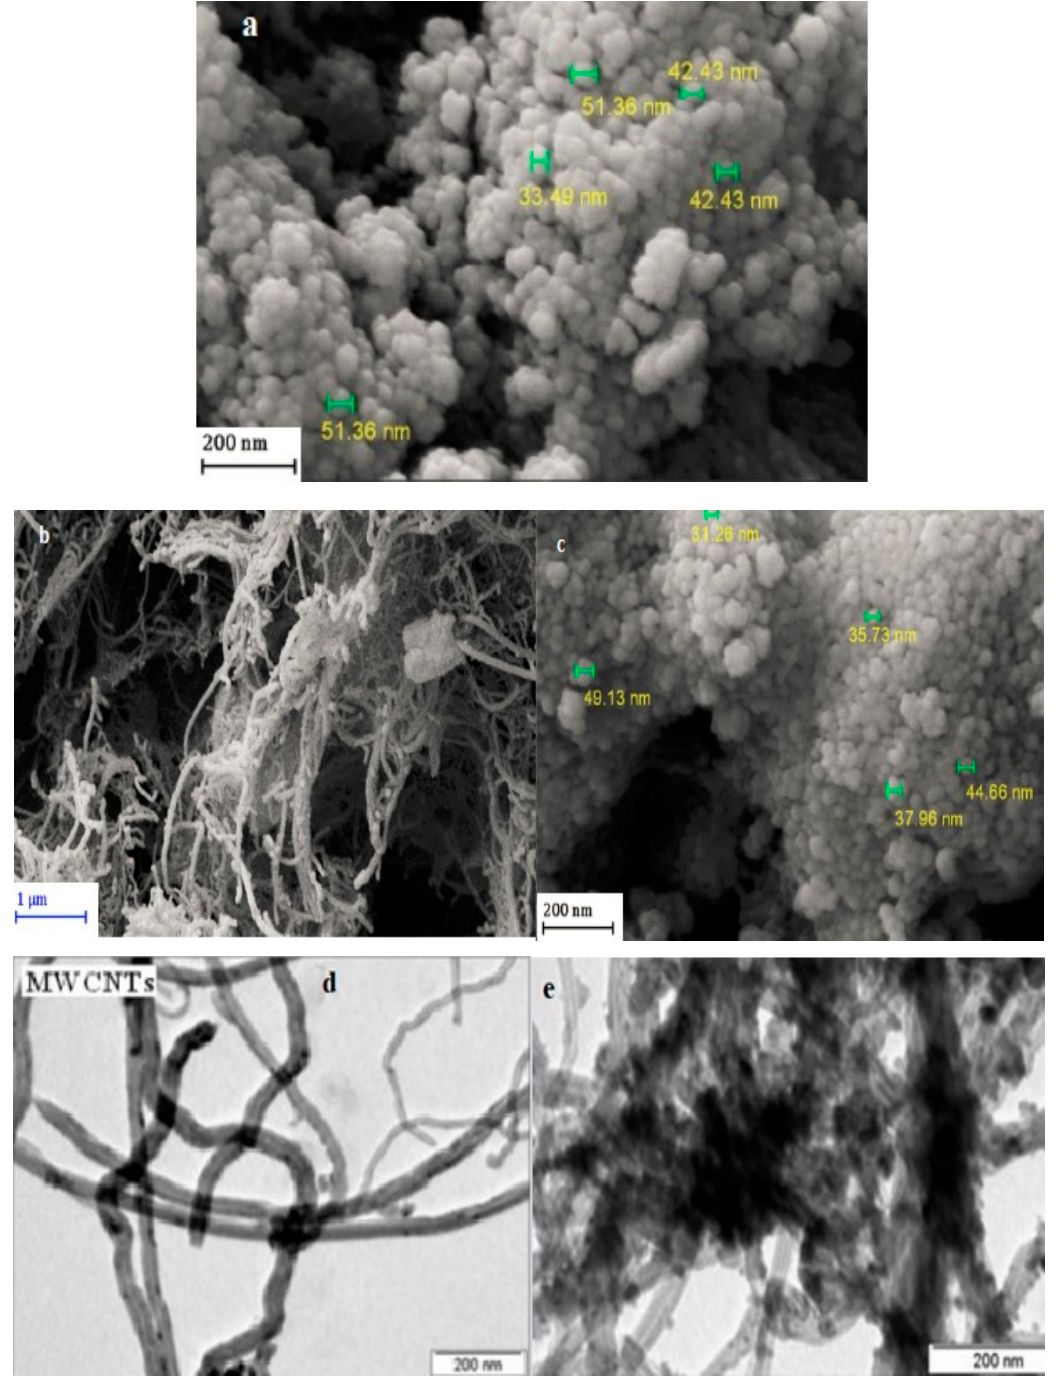
Figure 2. SEM image of CoFe 2 O 4 ( a ), MWCNTs/CoFe 2 O 4 ( b , c ), TEM image of MWCNTs ( d ), and TEM image of MWCNTs/CoFe 2 O 4 ( e ).